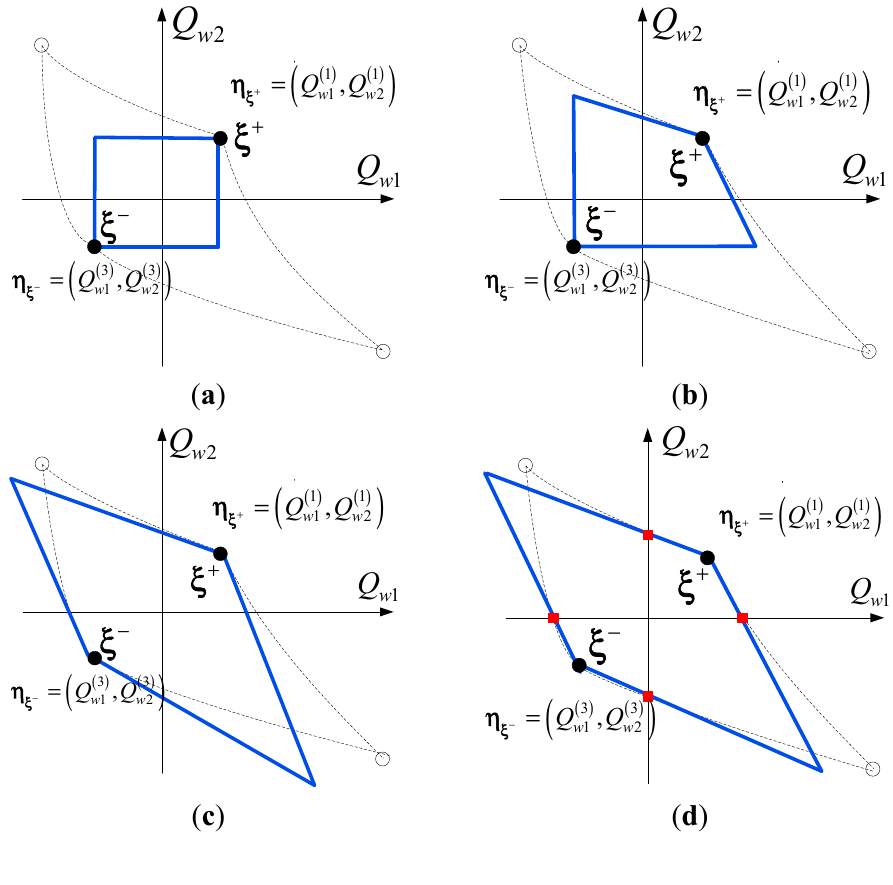
Figure 6. Four different linear approximations of Ω − and the tangent planes at near point ξ + ; ( c ) using the tangent planes ( b ) using near point ξ − ; ( d ) using the cutting planes formed by near and inner near points ξ + and ξ